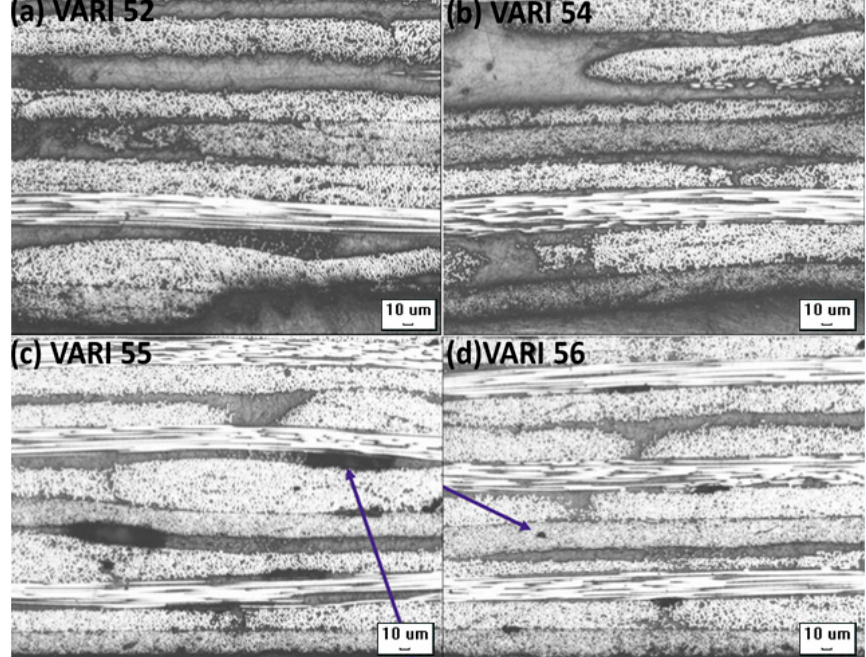
Figure 13. Micrographs showing the voids/porosities in various laminate configurations: ( a ) VARI 52 with no porosities; ( b ) VARI 54 with no porosities; ( c ) VARI 55 with macroporosities; and ( d ) VARI 56 with micro and macro porosities (all micrographs ×5 magnification).